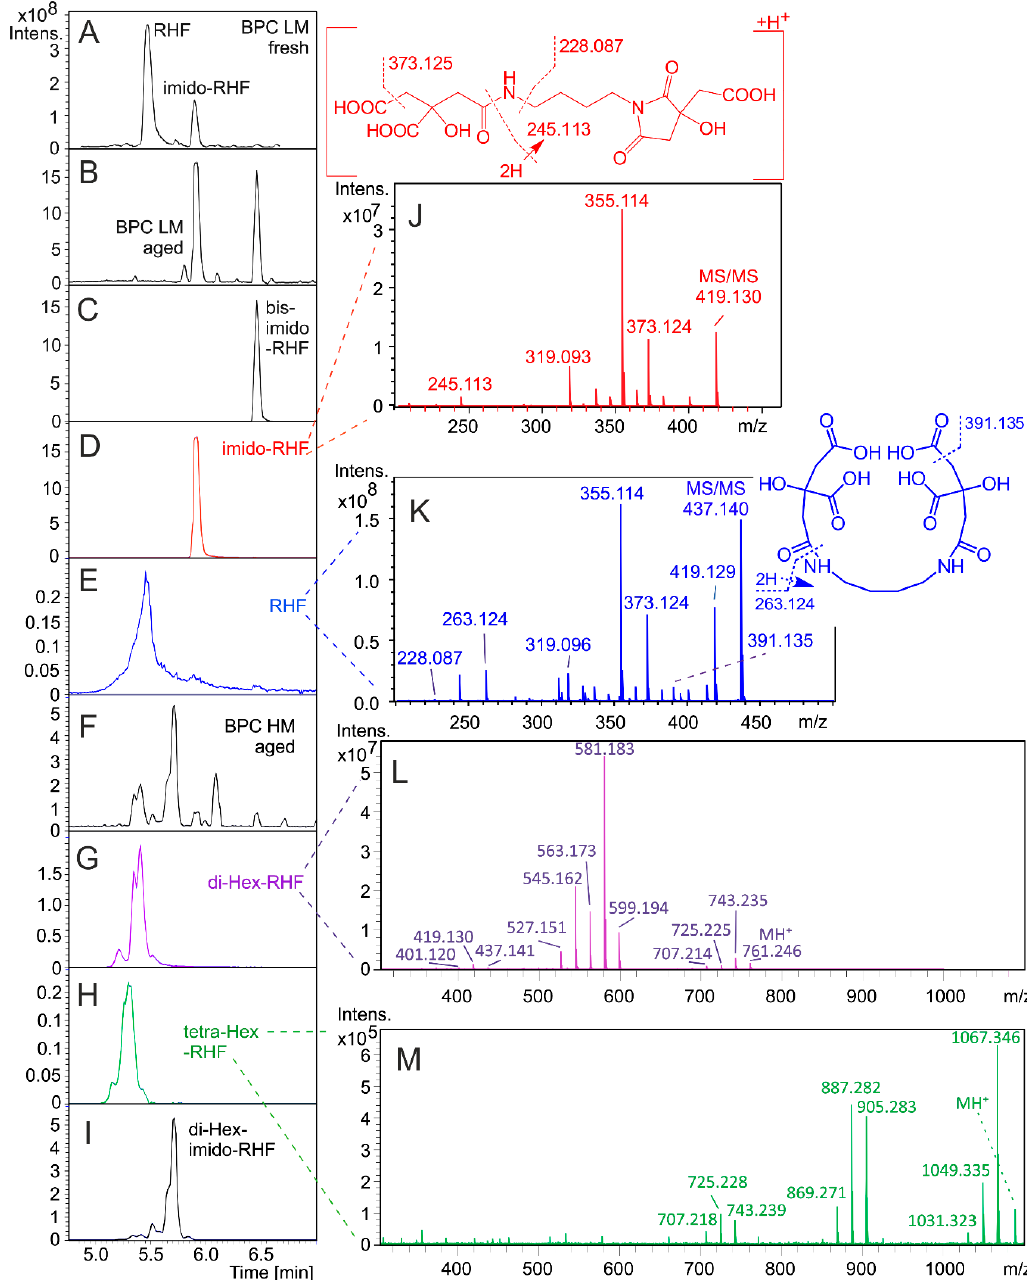
Figure 1. Chromatographic separation and tandem mass spectrometry of R. microsporus secondary metabolites. BPC: base peak chromatogram (CASI LM or HM windows), Hex stands for hexose. ( A , B ), BPC in the 200–700 Daltons mass range run on fresh or aged (5 months) lyophilizates; ( C – E ), reconstructed ion mass chromatograms corresponding to bis-imido-RHF, imido-RHF, and RHF, respectively (0.005 Dalton window). The BPC and selected ion chromatograms of di-Hex-RHF, tetra-Hex-RHF, and di-Hex-imido-RHF are shown in panels ( F – I ), respectively (all HM). Panels ( J – M ) refer to the product ion mass spectra (10 eV collisional energy) of imido-RHF, RHF, di-Hex-RHF, and tetra-Hex-RHF, respectively. The structure on the top indicates the intrinsic fragmentation in the RHF molecule.